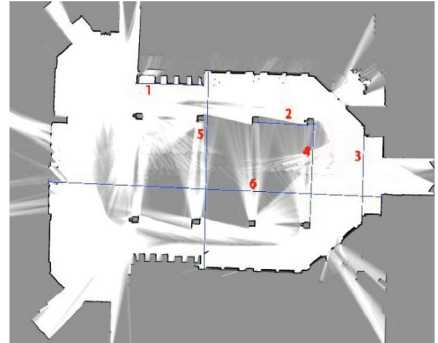
Figure 12: Mapping precision